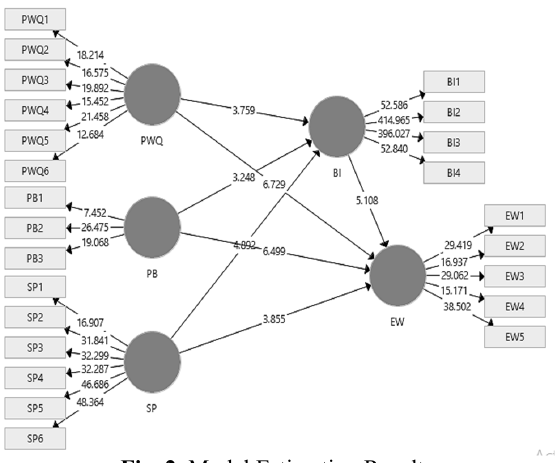
Fig. 2. Model Estimation